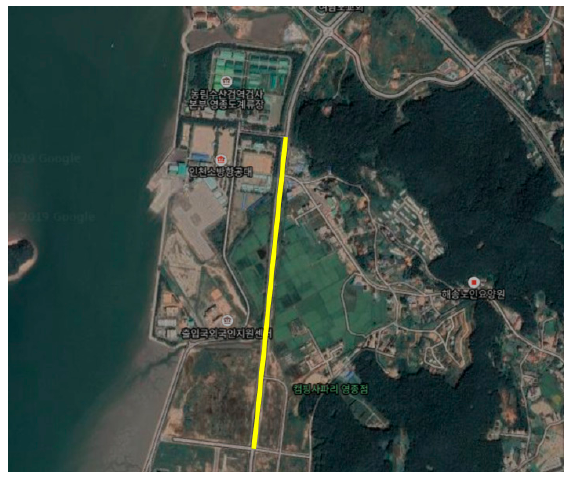
Figure 7. Test route for car-following situations.